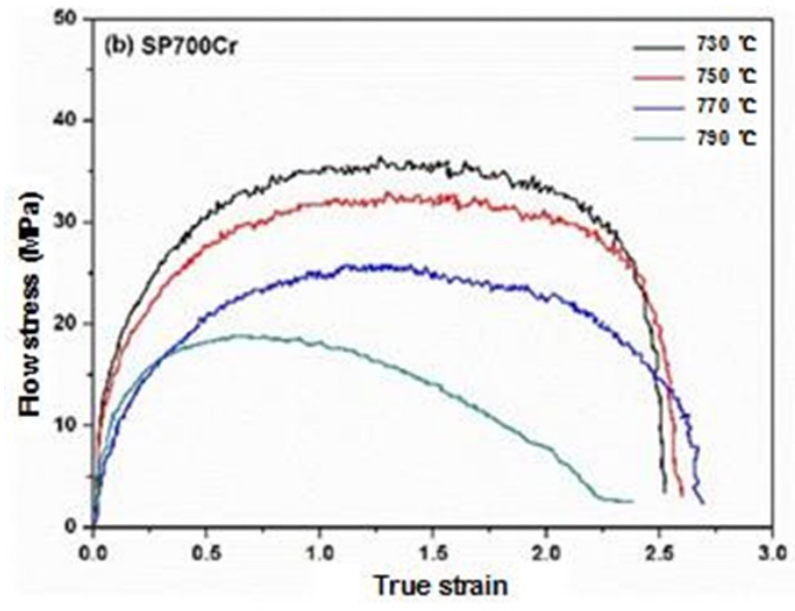
Figure 4. Flow stress-strain curves at elevated temperatures of forged ( a ) SP700 [14] and ( b ) SP700Cr alloys.